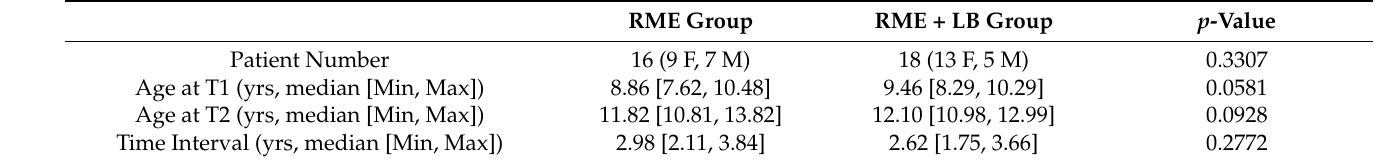
Table 1. The demographic information of the two groups. RME: rapid maxillary expansion; LB: lip bumper; F: female; M: male; yrs: years. The Chi-square test was performed for the gender distribution comparison between groups. The Mann–Whitney U test was performed for the age and time interval comparisons between groups. RME Group RME + LB Group p -Value Patient